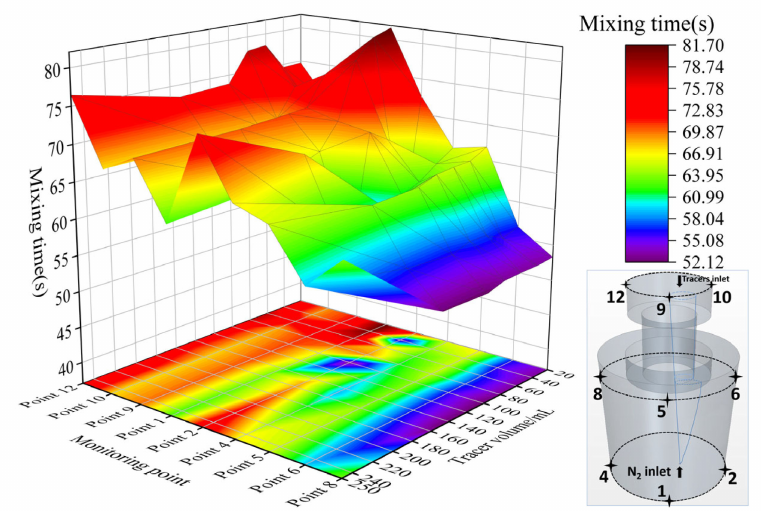
Figure 21. Comparison of the mixing time of different dosages of the KCl solution at different monitor